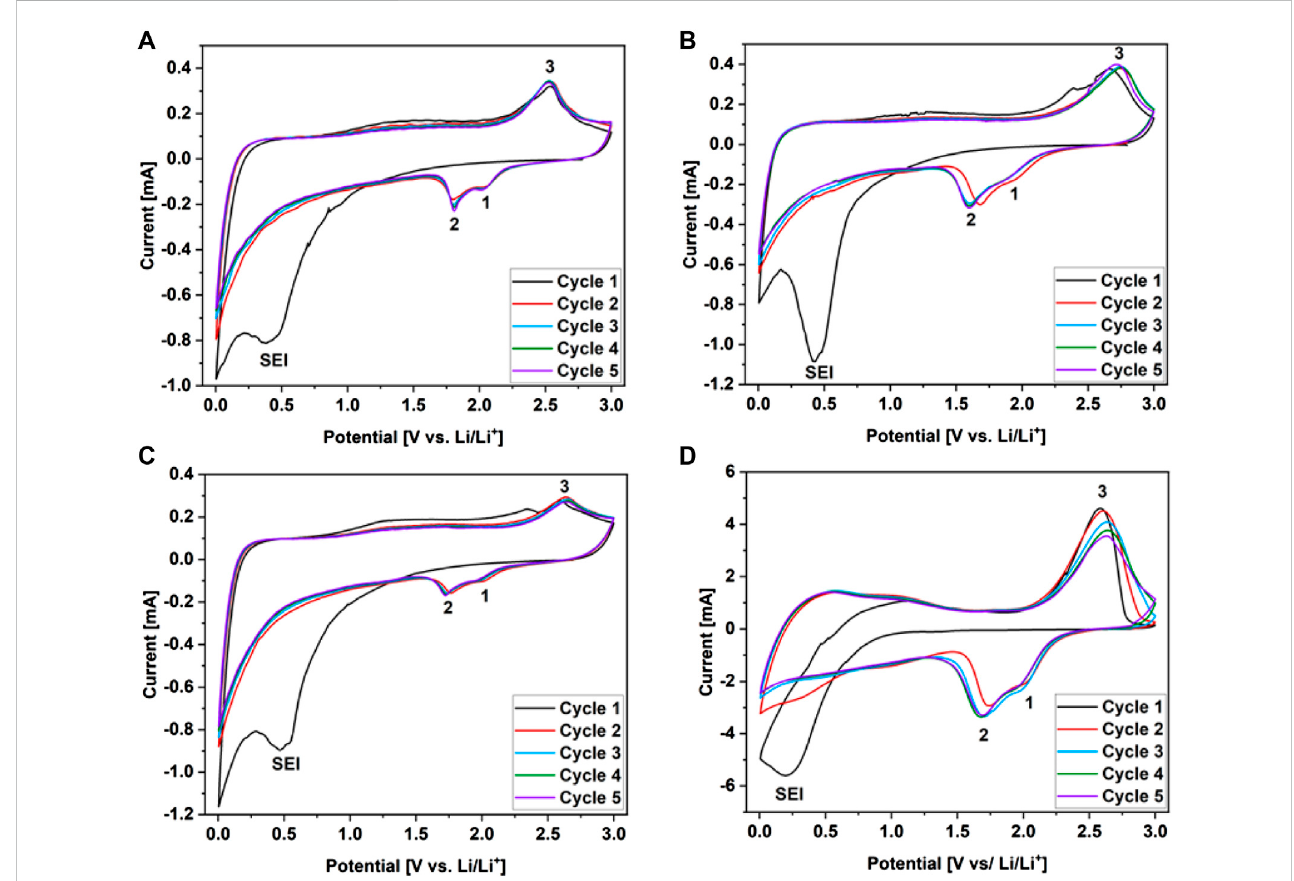
FIGURE 5 Cyclic voltammograms recorded over 0 – 3.0 V for (A) WS 2 /userGO1, (B) WS 2 /userGO2, (C) WS 2 /userGO3, and (D) ex-WS 2